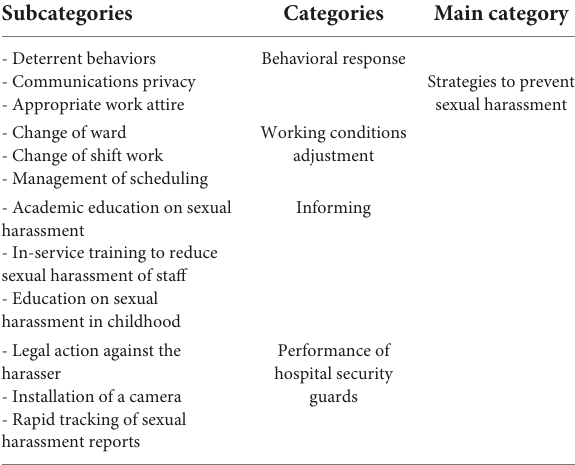
TABLE 4 Subcategories, categories, and main category extracted from qualitative content analysis.